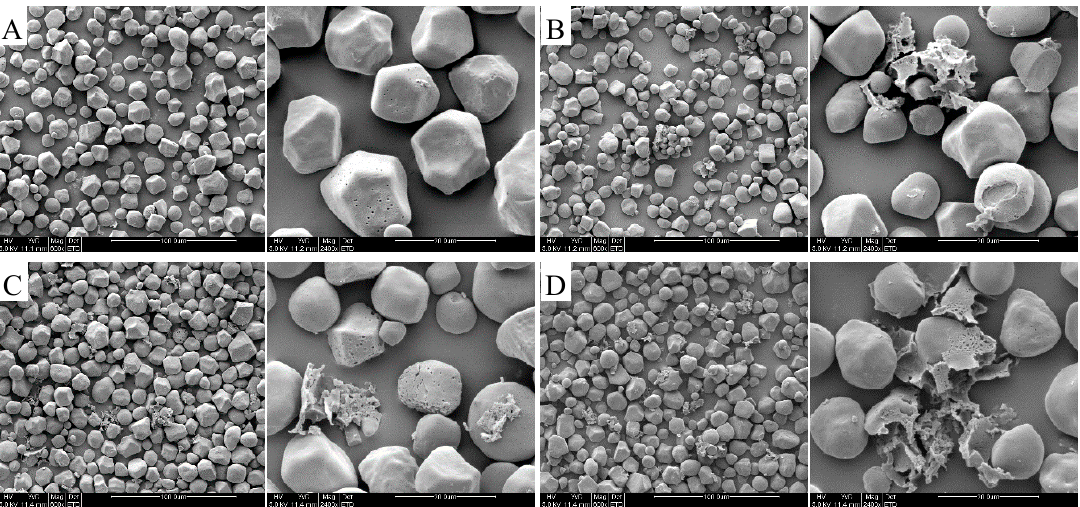
Figure 1. SEM of corn starch after EBI treatment ( A ) control, ( B ) 10 kGy, ( C ) 30 kGy, and ( D ) 50 kGy.